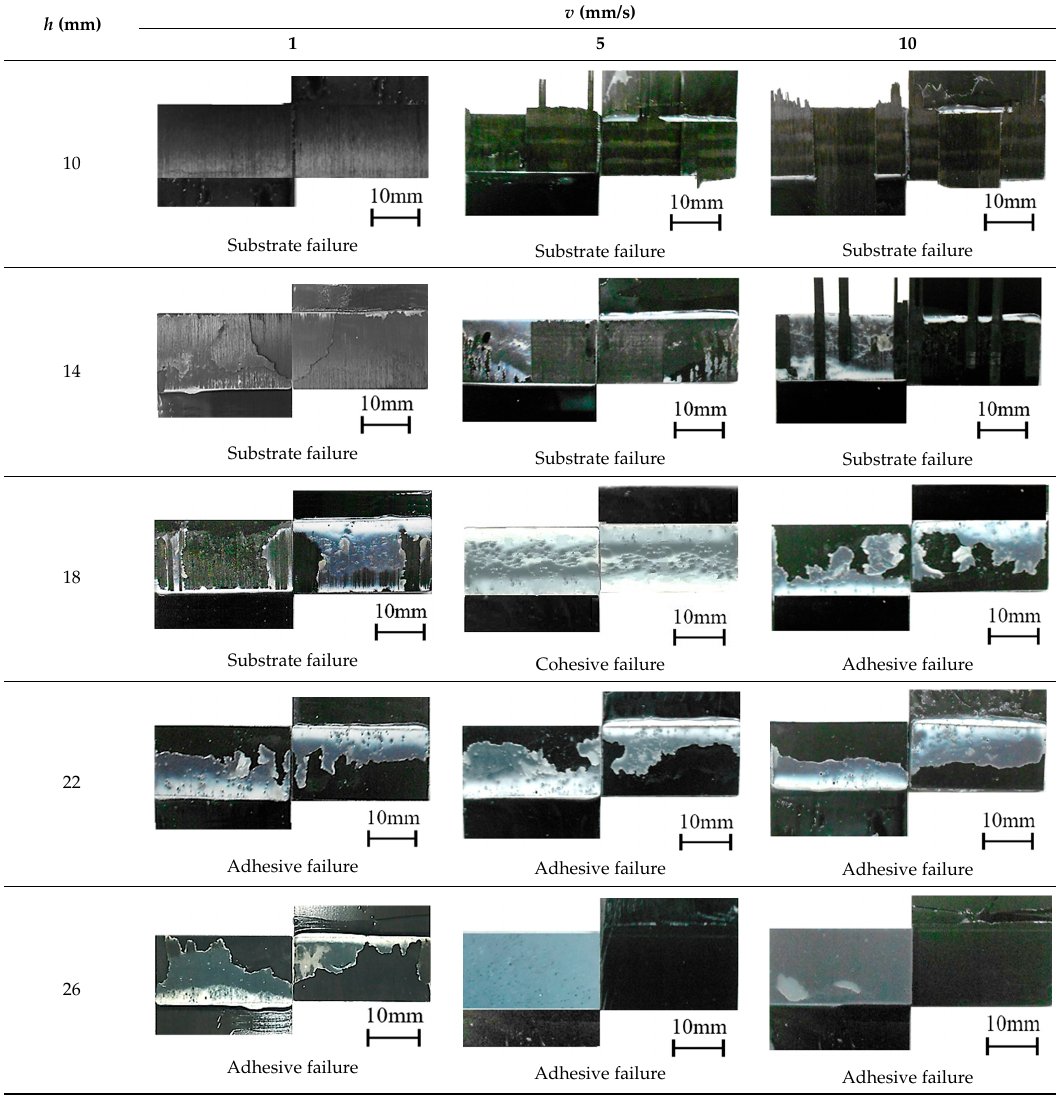
Table 5. Fracture modes of plasma-treated CFRP joints.